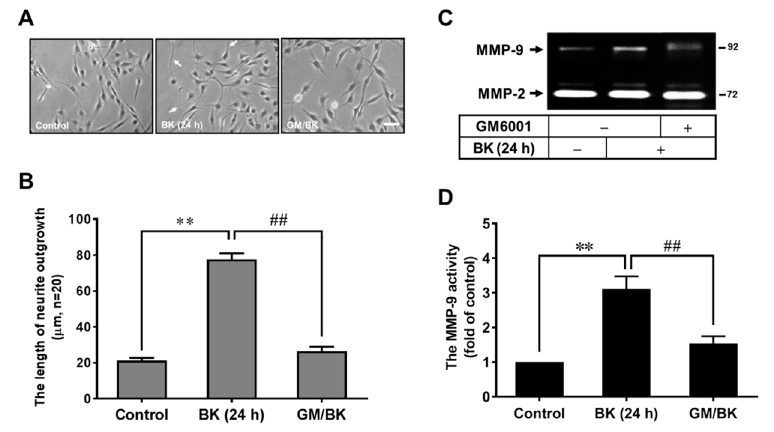
Figure 2. BK-induced RBA morphological change into neuron-like cells is mediated through an MMP-dependent manner. RBA cells were pretreated with GM6001 (10 μ M) for 1 h and then incubated with or without BK (10 nM) for 24 h. Representative phase-contrast images were obtained (( A ), scale bar = 20 μ m) and shown for 24 h ( A ) and the length of neurite fiber outgrowth at 24 were quantified (( B ), n = 20). Cells were pretreated with or without GM6001 (10 μ M) for 1 h before exposure to 10 nM BK for 24 h. The conditioned media were collected and analyzed by gelatin zymography ( C ) and quantified ( D ). The image represents one of at least three individual experiments. Data are expressed as the mean ± SEM of at least three independent experiments. ** p < 0.01, as compared with control. ## p < 0.01, as compared with BK alone.